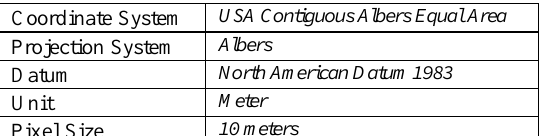
Table 1 . Metadata of training dataset.